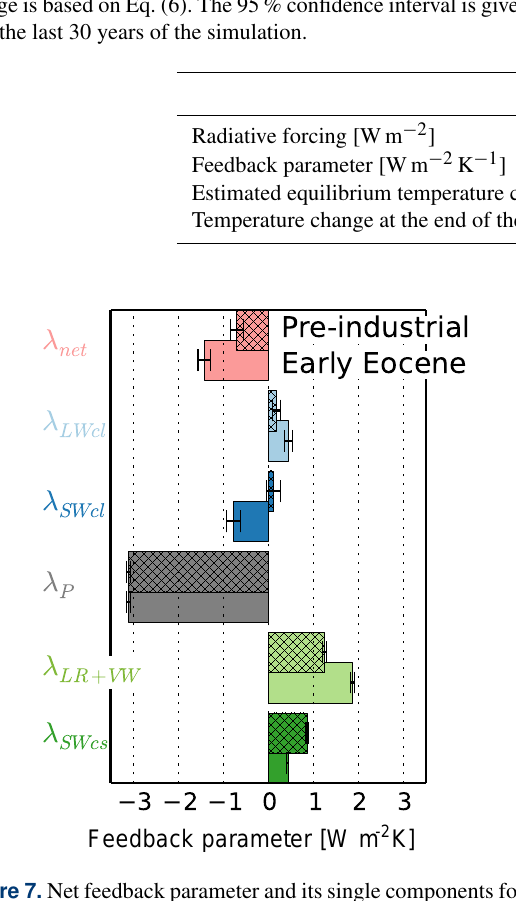
Figure 7. Net feedback parameter and its single components for the comparison of the forest world to the bright desert world. Hatched and plain bars show the feedback parameters for the pre-industrial climate and the early Eocene climate, respectively. The error bars refer to the 95% confidence interval.